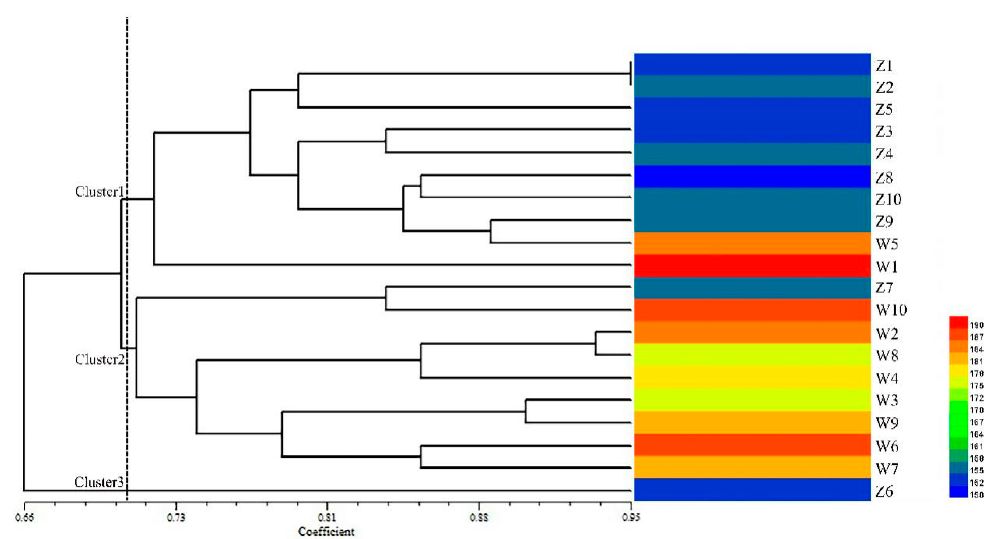
Figure 7. Cluster analysis of 20 E. sibiricus accessions with 15 candidate gene-based EST-SSR markers and the heatmap analysis of flowering days of the 20 E. sibiricus accessions.